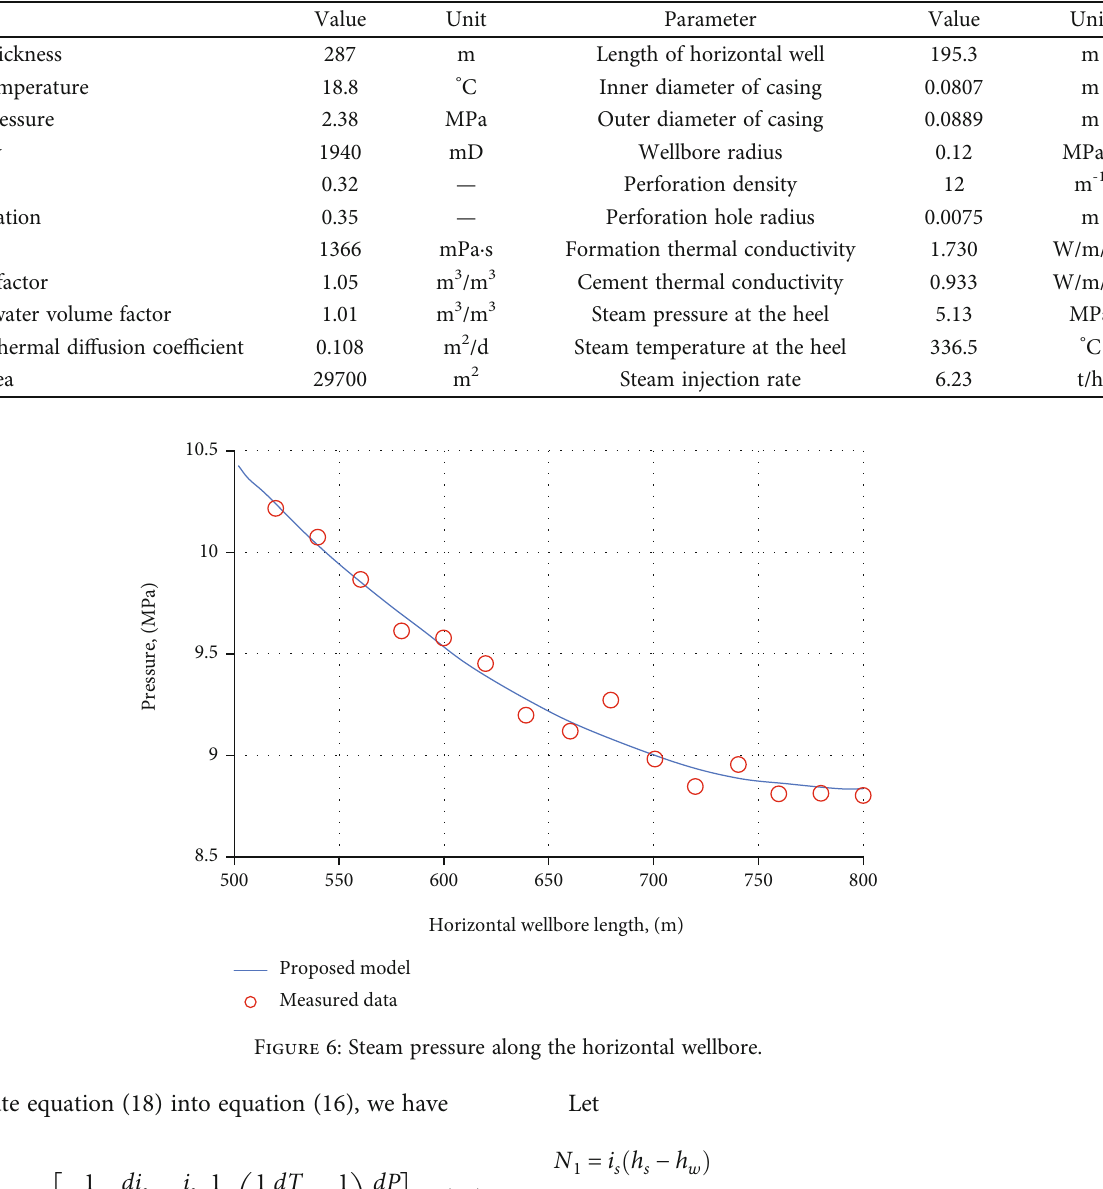
Table 2: Parameters of reservoir, wellbore and steam injection.